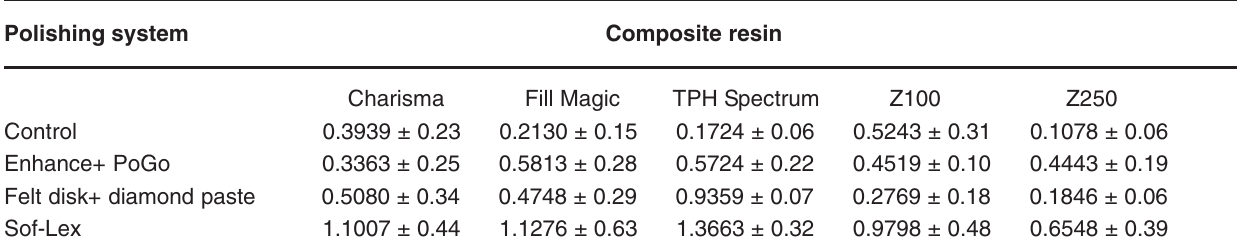
TABLE 3- Mean Ra values (µm) and standard deviations for the interaction between composite resins and polishing systems